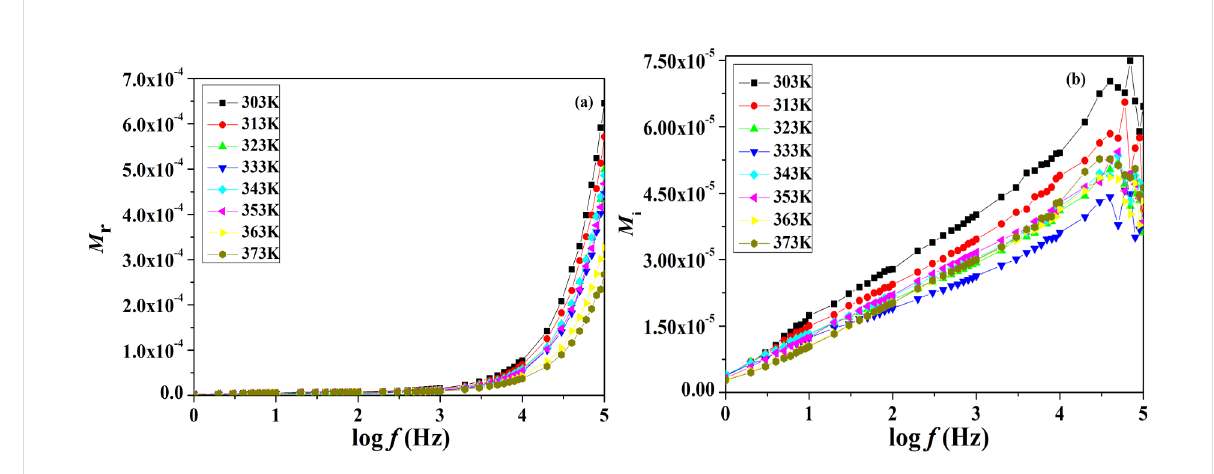
Figure 7: (a) Variation of the real part of the modulus of polymer gel electrolytes as a function of frequency at various temperatures. (b) Variation of the imaginary part of the modulus of polymer gel electrolytes as a function of frequency at various temperatures.